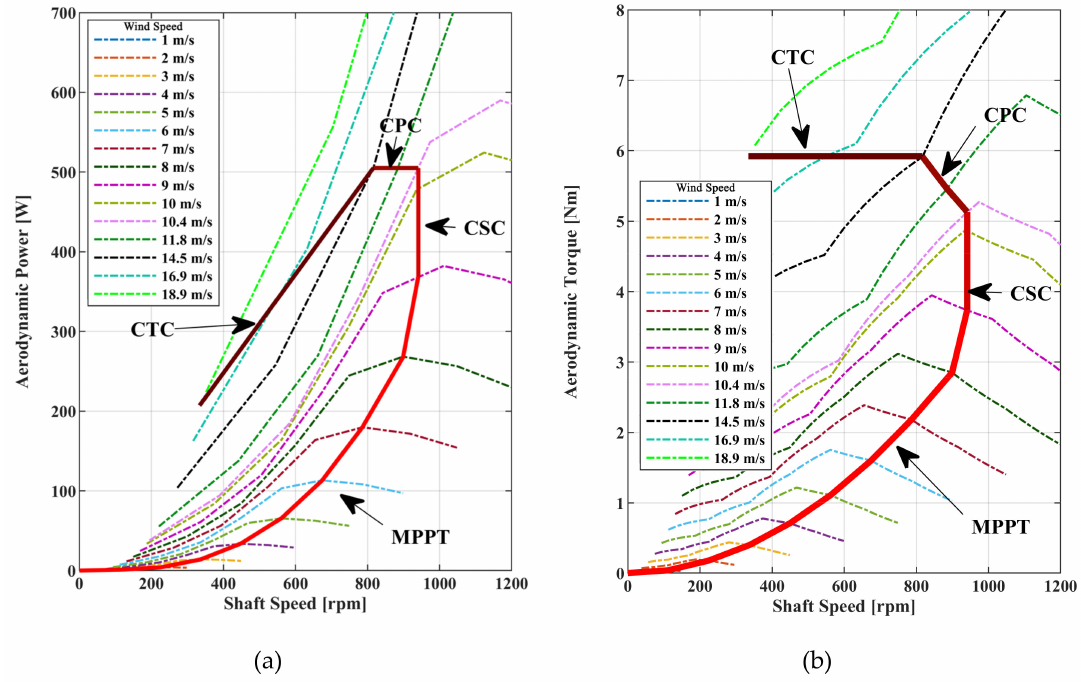
Figure 7. Regulation characteristics. ( a ) Regulation curve in ω m − P a plane. ( b ) Regulation curve in ω − T m a